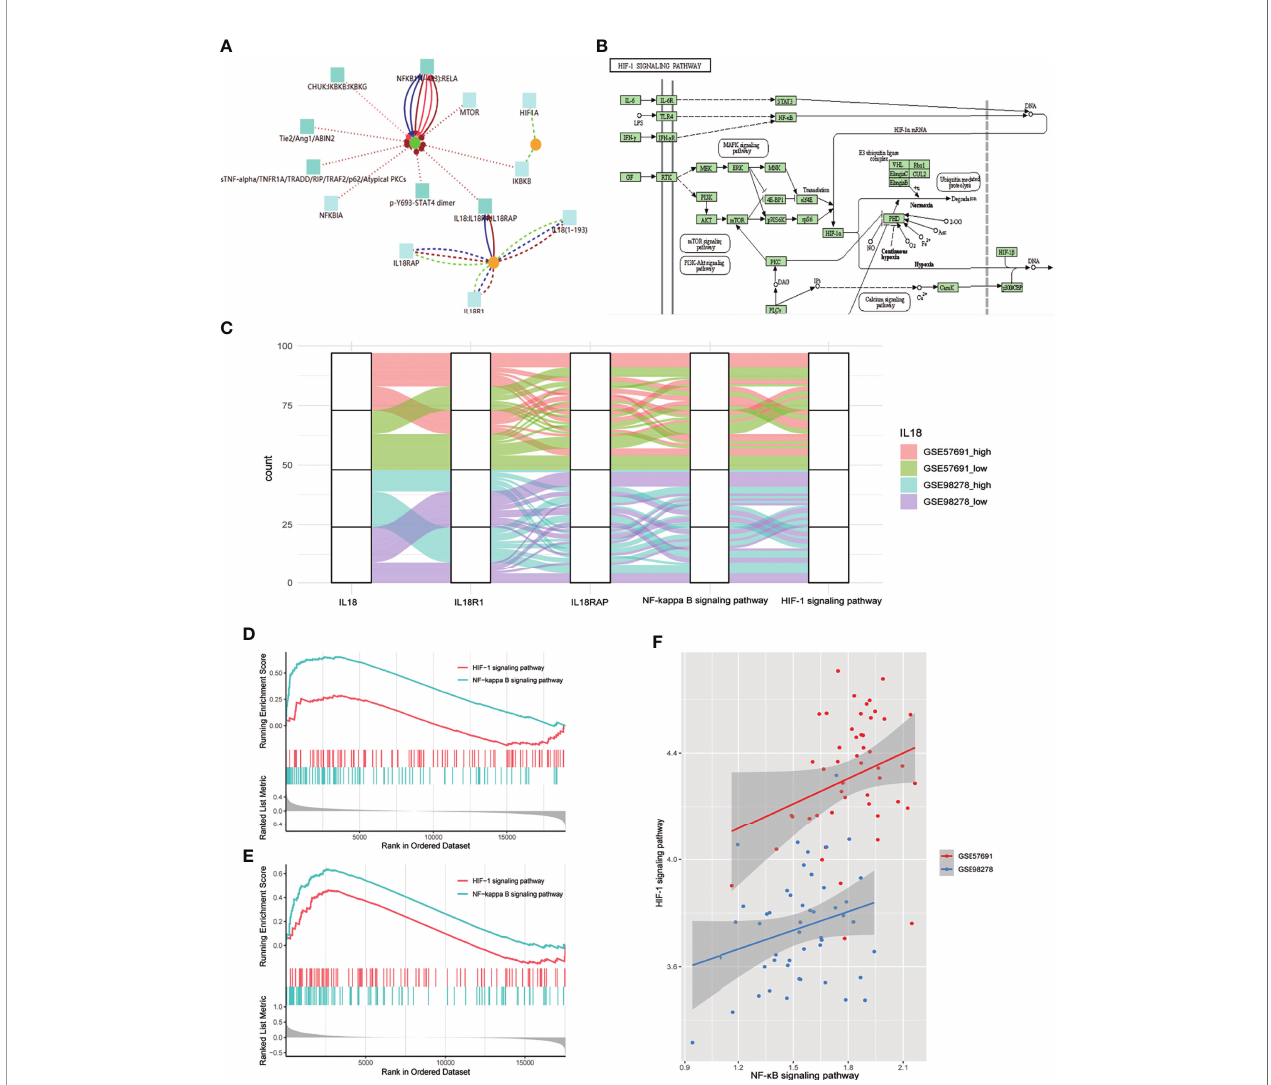
FIGURE 4 | NF- k B mediates the regulation of IL18 on HIF-1 signaling pathway. (A) Proteomics analysis of IL18/IL18R1 and HIF-1A based on CPDB. IL18/IL18R1 can promote nuclear entry of NF- k B. (B) After entering the nucleus, NF- k B promotes HIF-1A transcription and activates HIF-1 signaling pathway. (KEGG: hsa04066) (C) Sankey diagram of IL18,IL18R1,IL18RAP,NF- k B and HIF-1 signaling pathways in GSE57691 and GSE98278. (D) . GSEA based on IL18R1 expression (GSE57691). (E) GSEA based on IL18R1 expression (GSE98278). (F) Scatter plot of correlation between NF- k B and HIF-1 signaling pathway expression scores. The scores were calculated by GSVA(GSE57691 and